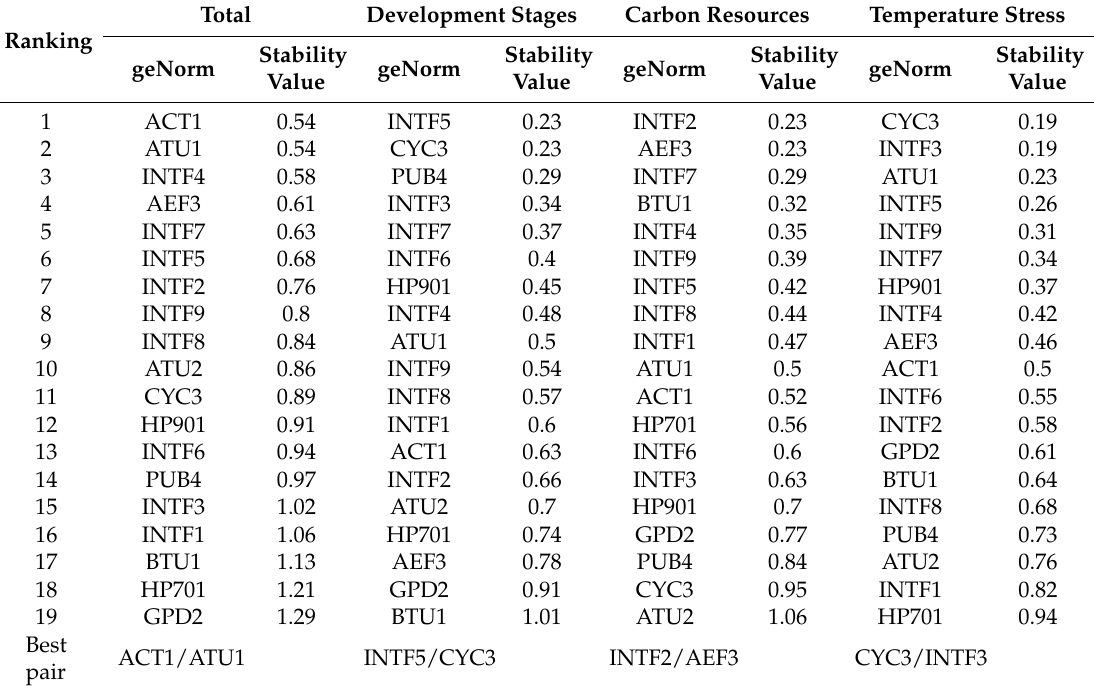
Table 2. Candidate genes ranked by the expression stability calculated by geNorm.